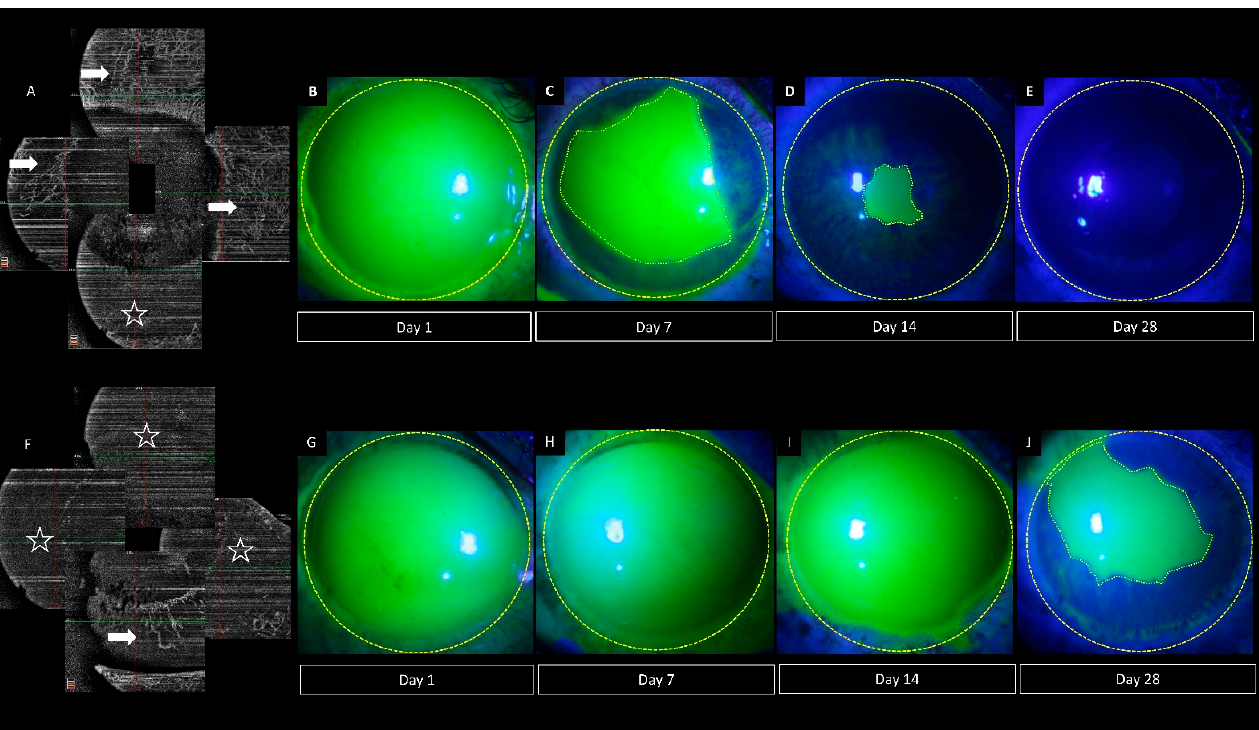
Figure 6. Collage of images depicting different rates of healing of total corneal epithelial defects in two cases of acute ocular burns. ( A , F ) Optical coherence tomography angiography images of both cases, showing greater ischemia in the eye in the lower panel when compared to the upper panel (white arrows denote the perfused areas while the white stars denote the non-perfused zones). The corresponding epithelial defect of the patient in the upper panel healed faster with a completely epithelialized surface at the 1-month visit ( B – E ) when compared to the healing of the patient in the lower panel with a persistent defect at the end of 1 month of follow up ( G – J ) .